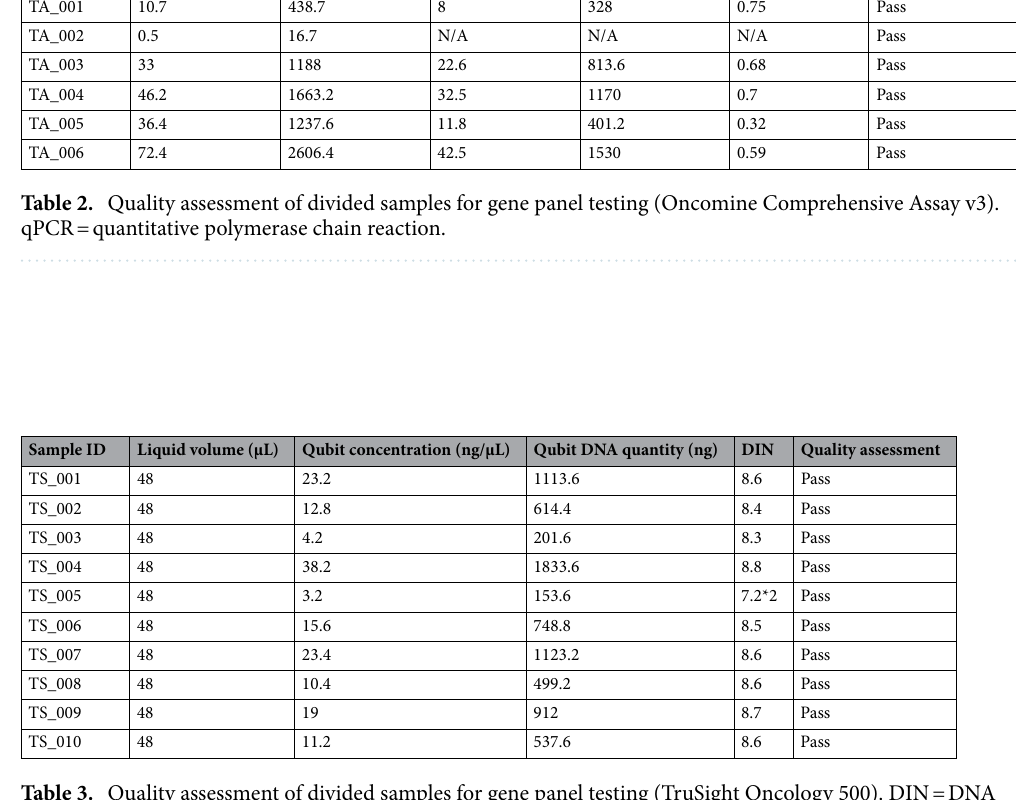
Table 3. Quality assessment of divided samples for gene panel testing (TruSight Oncology 500). DIN = DNA integrity number.